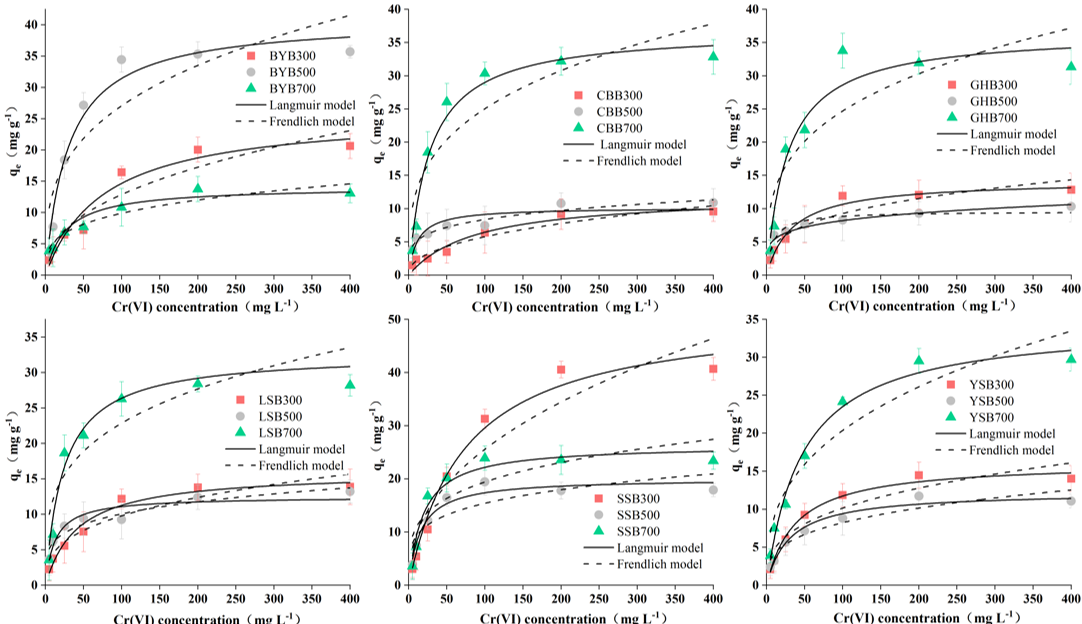
Figure 4. Isotherm fitting results of different biochar types (pH: 2; dosage of biochar: 1.2 g·L − 1 ; reaction time: 1440 min).